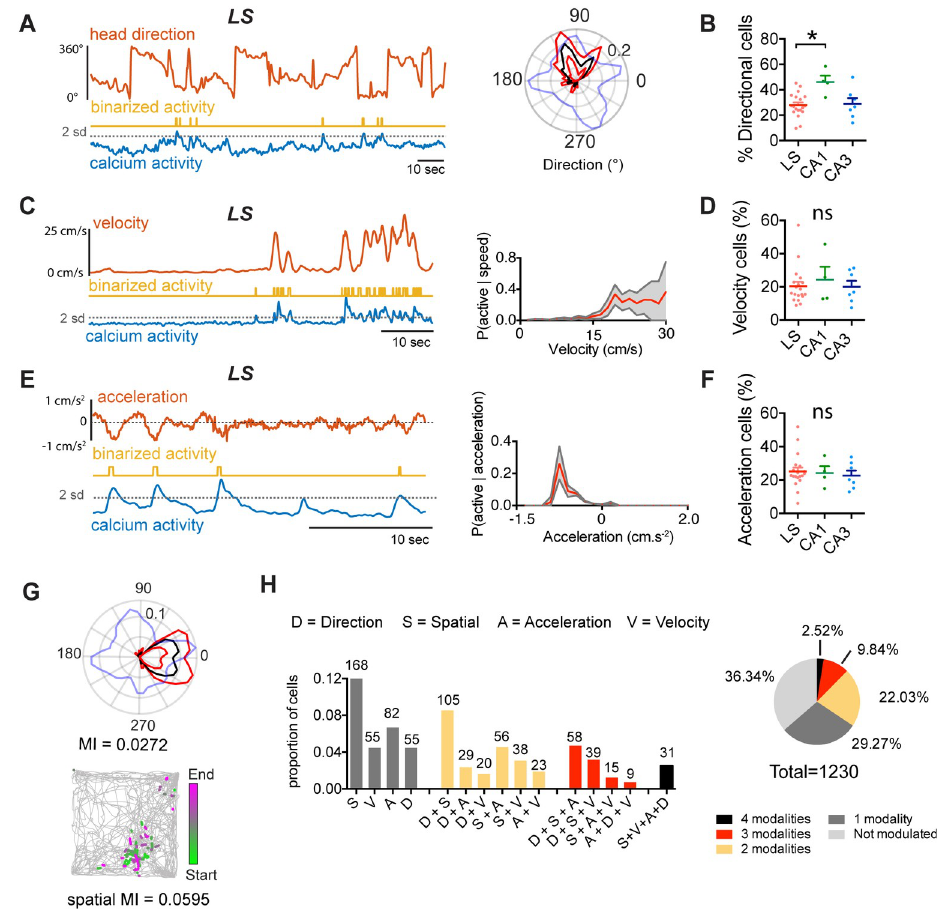
Fig 5. LS GABAergic cells encode direction, speed, and acceleration. ( A) Left: activity of an example LS neuron during free exploration in an open field; top: HD (red); middle: binarized activity (yellow); bottom: raw calcium activity (blue). Right: corresponding polar plot indicating the probability of the cell being active as a function of the animals’ HD with (black, p(active | direction); red lines indicate 95% upper and lower percentile. Blue line indicates the normalized time spent for each direction. MI calculated using 40 bins of 9˚ (S15 Fig). (B) Proportion of significantly directionally modulated cells in LS, dCA1, and dCA3. (C) Left: activity of an example LS neuron during free exploration modulated by velocity (top, red); middle: binarized activity (yellow); bottom: raw calcium activity (blue). Right: Tuning curve for velocity for the example cell (red) with 95% upper and lower percentile in gray. MI calculated using 20 bins. (D) Proportion of significantly speed modulated cells in LS, dCA1, and dCA3. (E) Left: activity of an example LS neuron during free exploration modulated by acceleration (top, red); middle: binarized activity (yellow); bottom: raw calcium activity (blue). Right: Tuning curve for acceleration for the example cell (red) with 95% upper and lower percentile in gray. MI calculated using 20 bins. (F) Comparison of proportions of significantly modulated cells for each region. (G) Example of an LS cell that is both significantly head direction modulated (left), as well as spatially modulated (right). (H) Left: proportion of cells that are significantly modulated by only one modality (gray), 2 modalities (yellow), 3 (red) or all 4 of the investigated variables (black). The number above the bars indicates the absolute number of cells found to be modulated in the total population ( n = 1,230 cells, n = 19 mice). Right: absolute proportion of cells modulated by any combination of variables. Test used in B, D, F: Kruskal–Wallis test with Dunn’s multiple comparisons test. � , p < 0.05. The underlying data can be found in S1 Data. A, acceleration; D, direction; HD, head direction; LS, lateral septum; MI, mutual information; ns, not significant; S, spatial coding; V, velocity. viral vector [65] and assessed the targets of the dorsal CA1-lateral septum (dCA1-LS) as well as dorsal CA3-LS (dCA3-LS) projections (Fig 6). For either dCA1 or dCA3 injections (Figs 6A and S19), we observed a direct pathway from the principal cells of the hippocampus, via the LS, leading to dense innervation of the MS (Fig 6B) and the hypothalamic regions (Fig 6C).